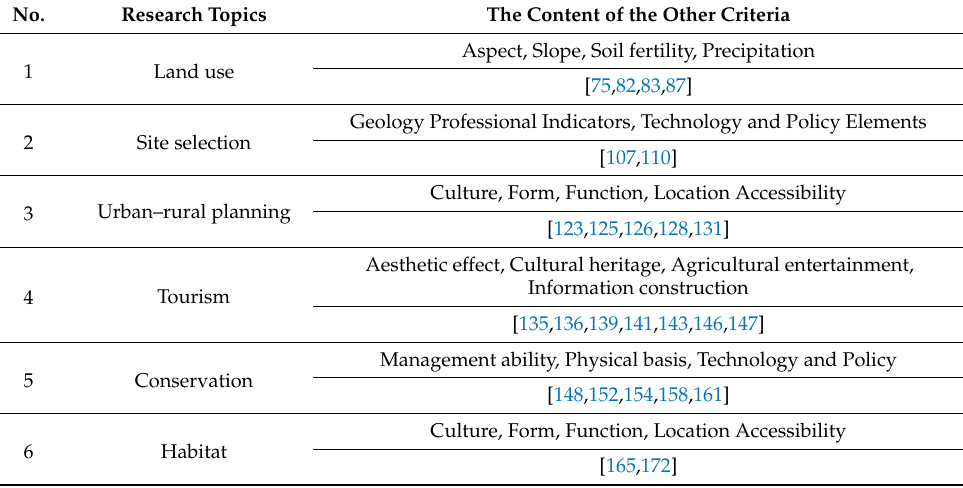
Table 6. Summary of criteria other than economy, society, and